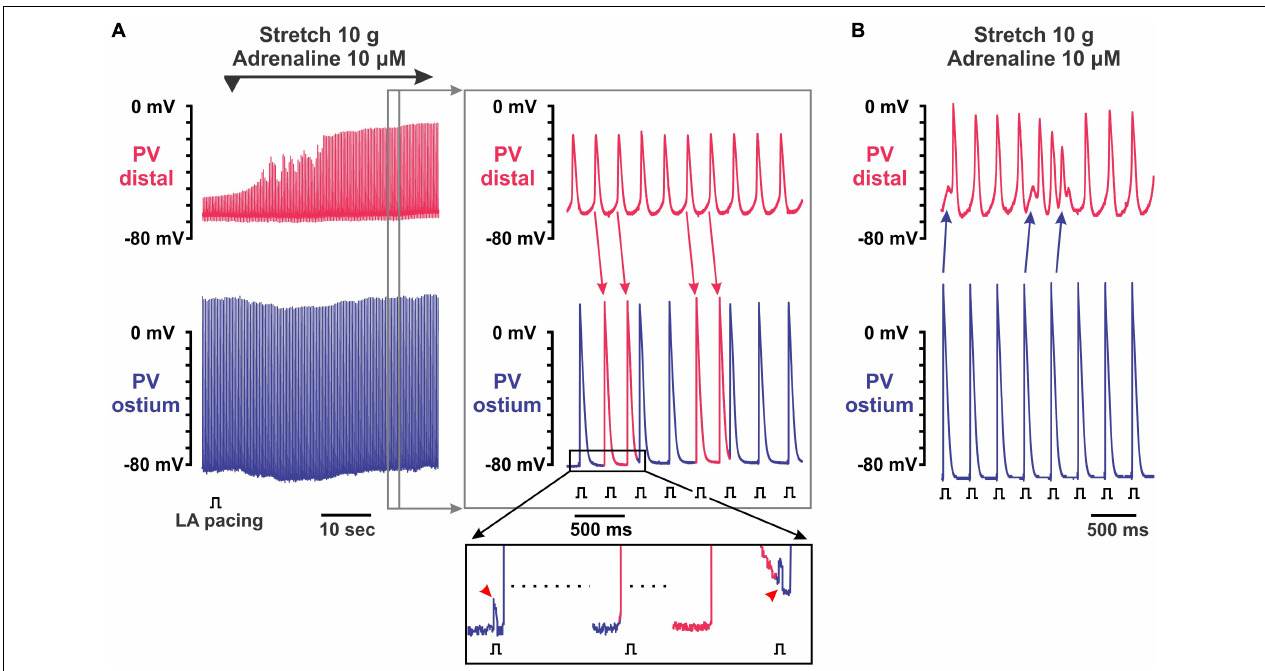
FIGURE 4 | Complex electrical activity recorded in pulmonary vein (PV) preparations under 10 µ mol/L adrenaline applied during 10 g stretch. Two simultaneous microelectrode recordings from PV distal (top recording in red) and PV ostium (bottom recording in blue) are shown. (A) Recovery of intra-PV conduction with arrhythmogenic activity after application of 10 µ mol/L adrenaline in 10 g stretched PV. Left panel shows a continuous 1-min recording of adrenaline application, while right panel represents an enlarged section of the left recording indicated by a gray rectangle. Spontaneous activity was induced in distal PV and not suppressed by left atrial (LA) pacing. Instead, a faster rhythm in distal PV interfered with a slower rate of electrical pacing resulting in frequent atrial extra beats (shown as red action potentials in PV ostium recordings; red arrows indicate propagating PV distal beats). (B) Burst of fast electrical activity triggered in distal PV by atrial extra beat interfered with intrinsic PV